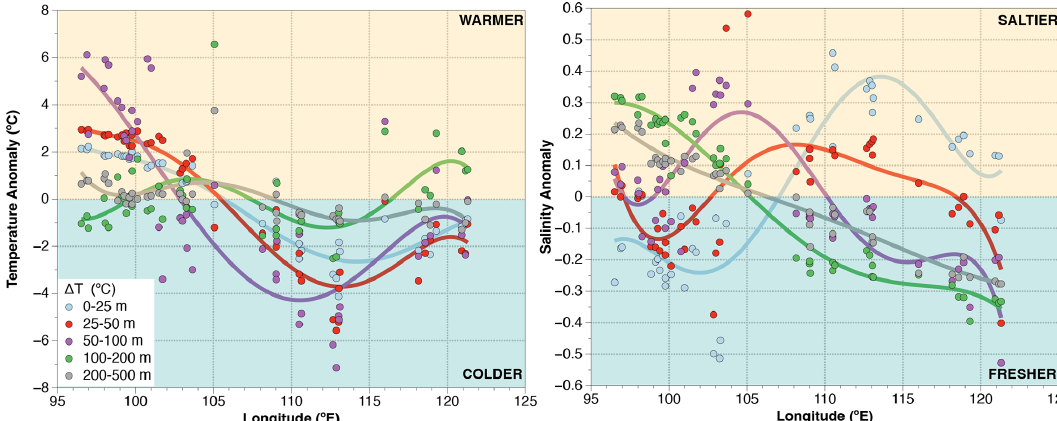
Figure A1. Longitudinal distribution of temperature and salinity anomalies across the upper 500m of water column. Anomalies are calculated by subtracting the mean of all sites for a given depth interval (e.g., 0–25, 25–50m) from the data of a station for the same depth interval. Positive (negative) values are centered off Sumatra (off Java) showing a strong zonal trend. The largest temperature change occurs at 50– 100m, roughly corresponding to the depth of the thermocline.